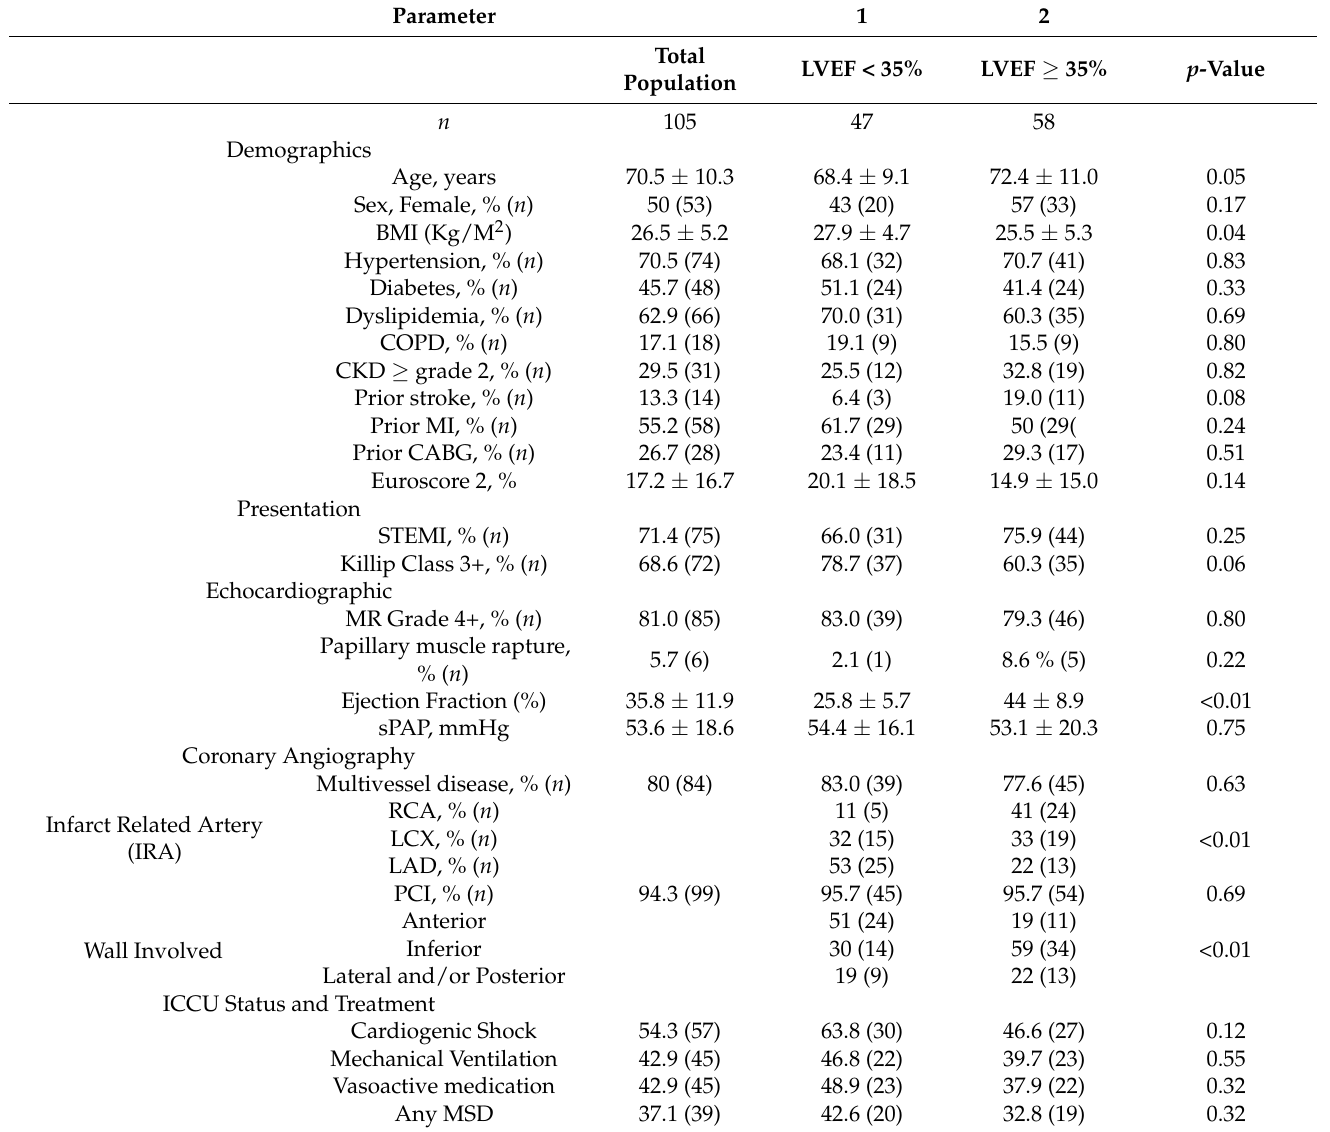
Table 1. Baseline Patient